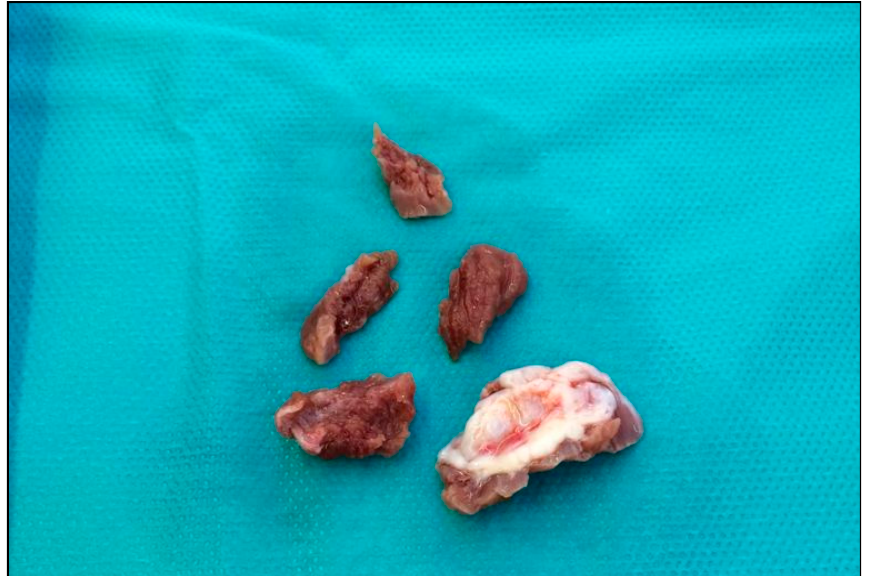
Figure 2. Surgical specimen showing the typical endocardial fibrous plaque (contact lesion) produced by the repeated contact of the mitral leaflets with the hypertrophic septum.